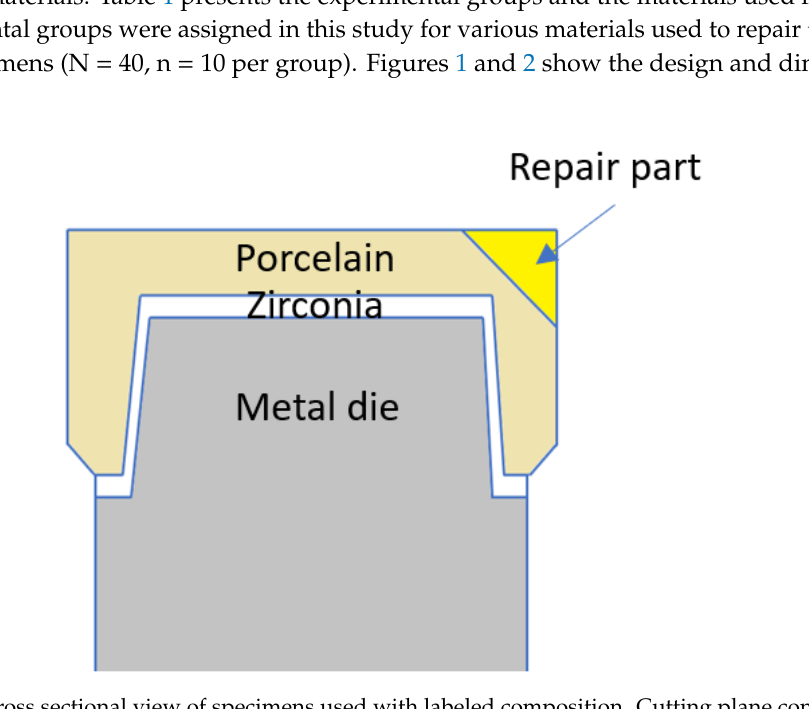
Figure 2. Cross sectional view of specimens with standard dimensions in millimeters. Cutting plane containing the plane of symmetry of the repaired part and the cylinder axis. 2.2. Preparation of Zirconia Copings Standardized identical aluminum dies were fabricated. One of the dies was scanned digitally with a digital laboratory scanner (inEos Blue, Sirona, Charlotte, USA) after coating the surfaces with a contrast spray (IPS Contrast Spray Labside, Ivoclar Vivadent, Schaan, Liechtenstein). Zirconia copings were designed using the software (inLab 3.88, Sirona). Die spacer thickness of 10 μm was